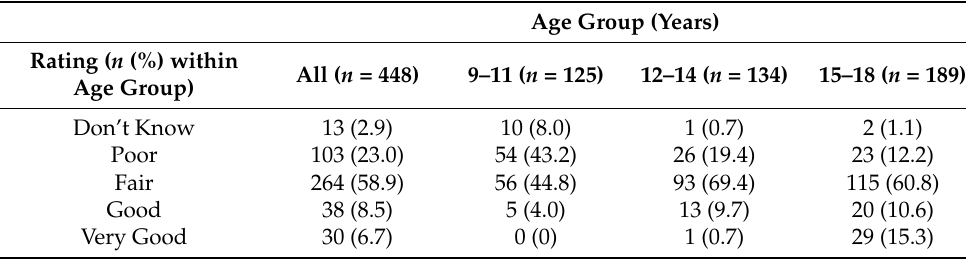
Table 3. Rating of Definitions of Health in the cohort and by age